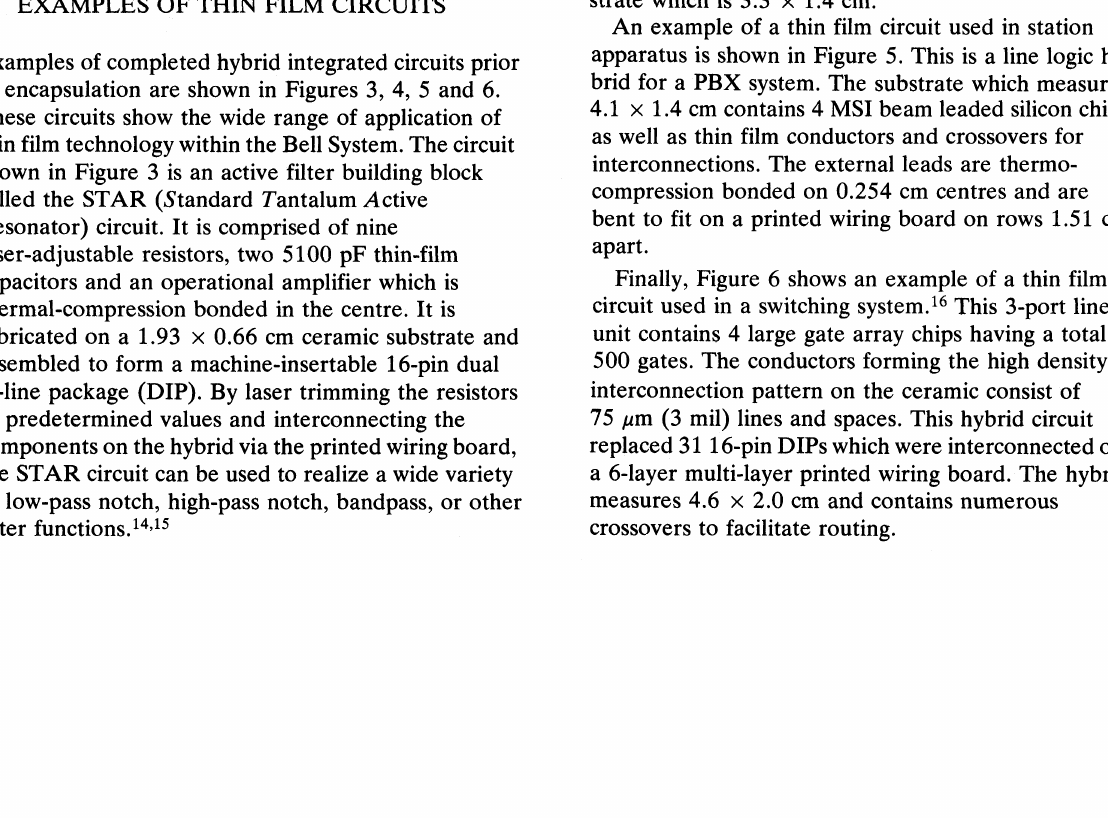
FIGURE 2 Large substrate (9.4 x 11 cm) with 60 thin film